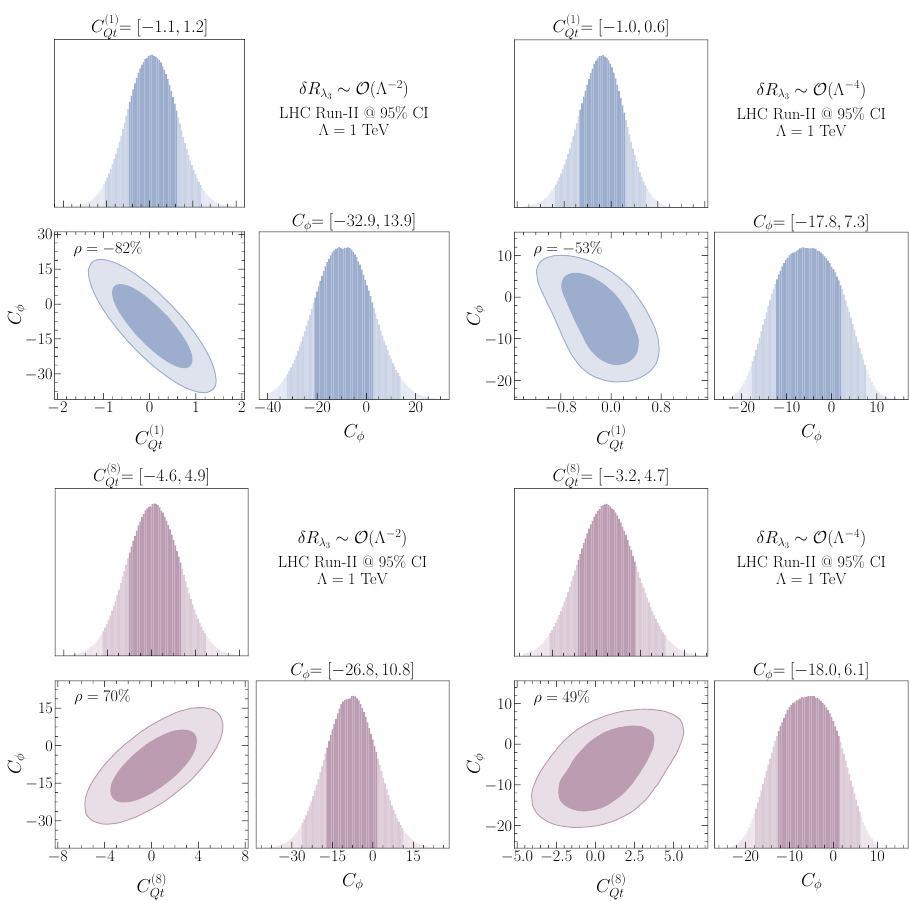
Figure 10 . The 68% and 95% highest density posterior contours of the posterior distribution from the fits of C φ with the four-top Wilson coefficient C (1) (top panels) and C φ with C (8) Qt Qt (bottom panels). We also show the marginalised one-dimensional posteriors for each of the Wilson coefficients, with their 68% and 95% HDPIs and, on top of the corresponding figures, the numerical 95% CI bounds. The limits correspond to values of the Wilson coefficients evaluated at the scale Λ = 1 TeV. On the left we used the linear scheme in δR λ while on the right we include effects up 3 to O (1 / Λ 4 ) in δR λ 3